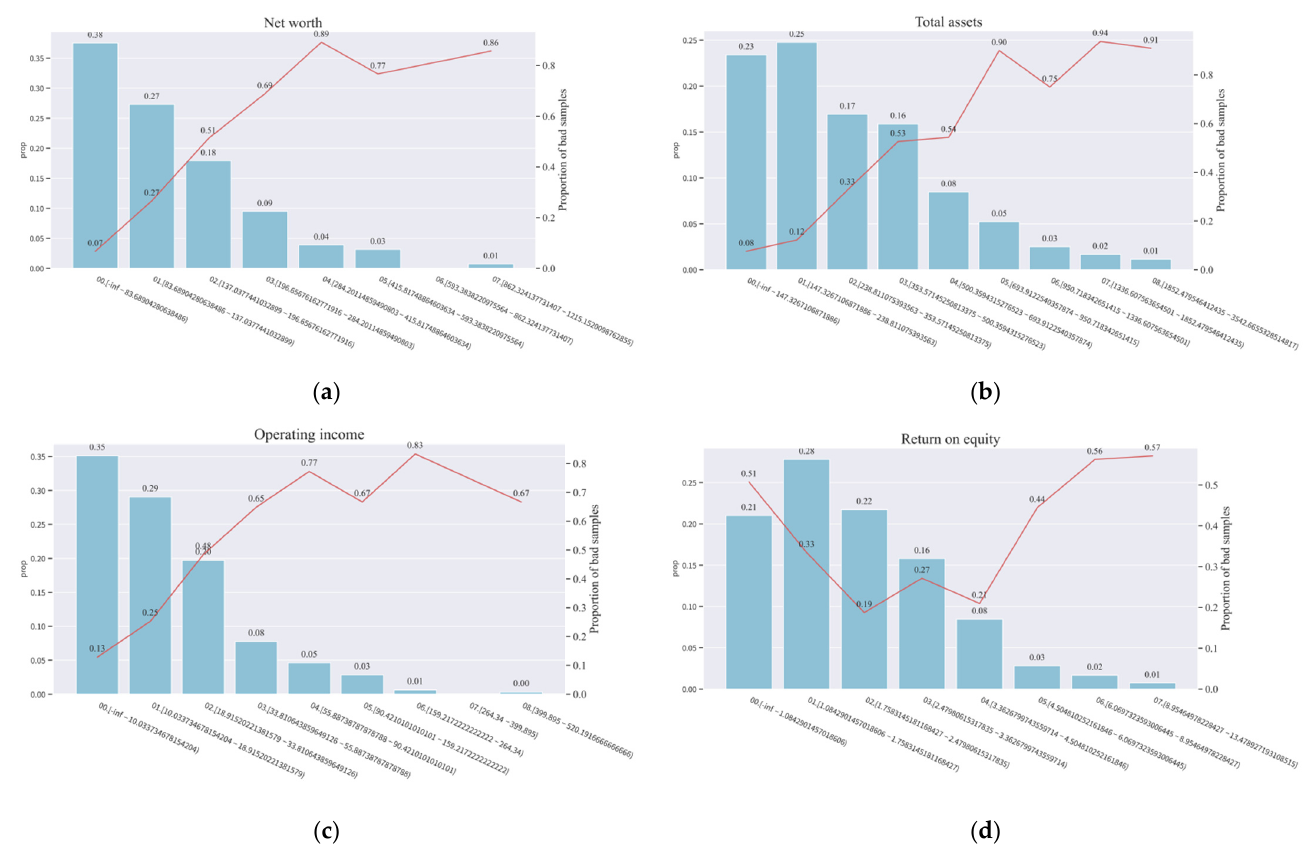
Figure 6. Monotonicity analysis of LGFV index bins. ( a ) Net worth; ( b ) total assets; ( c ) operating income; ( d ) return on equity.